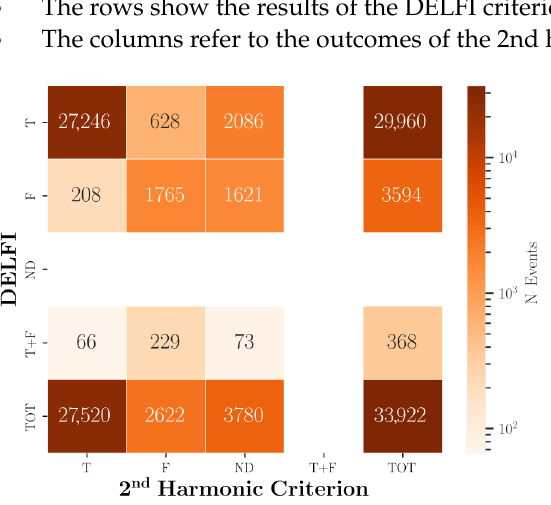
Figure 8. Validity assessment: 2nd harmonic and DELFI outcomes.